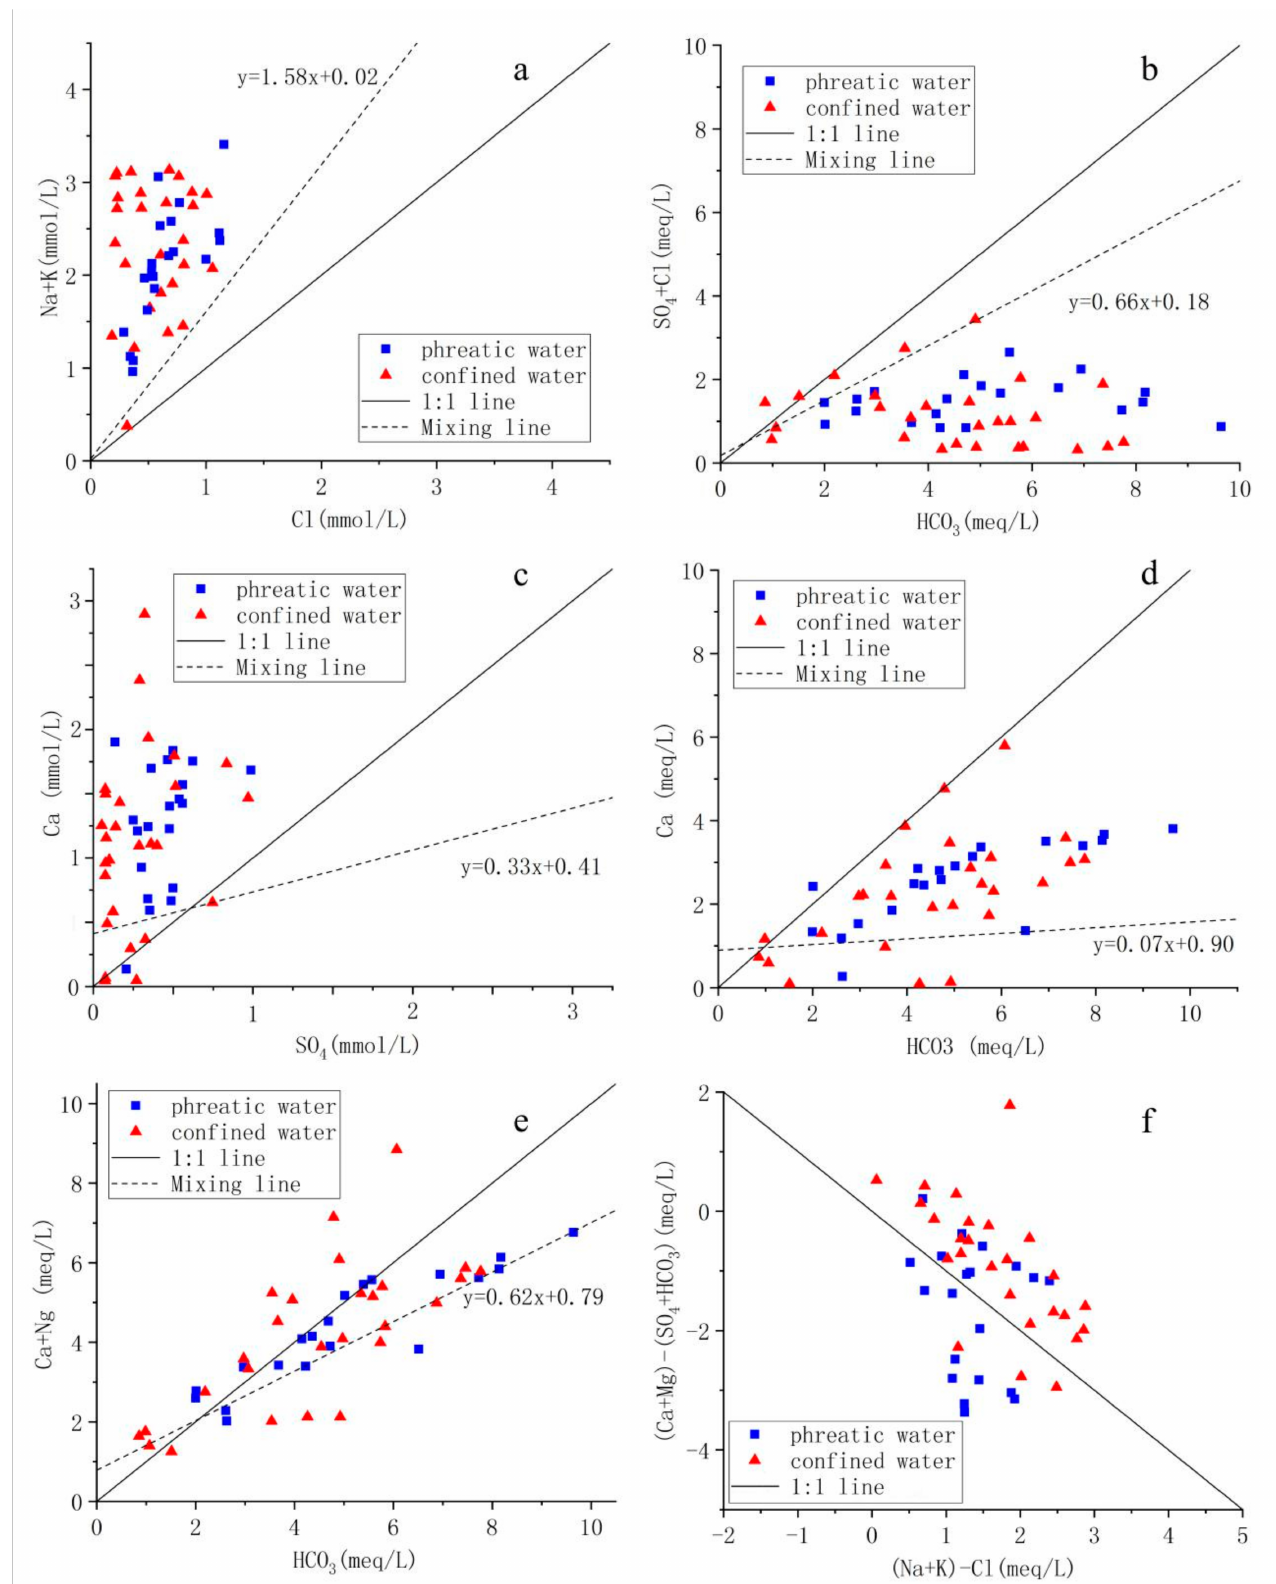
Figure 5. Relationships between the rates of the selected ions of